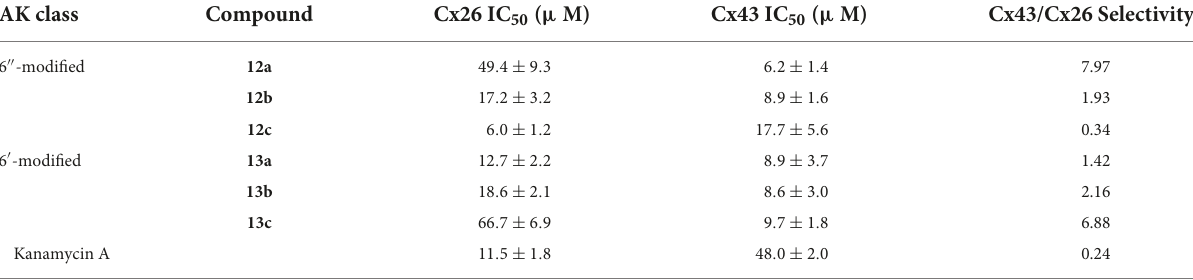
TABLE 6 IC 50 of selected 6 (cid:48)(cid:48) - and 6 (cid:48) -modified AKs toward Cx26 and Cx43